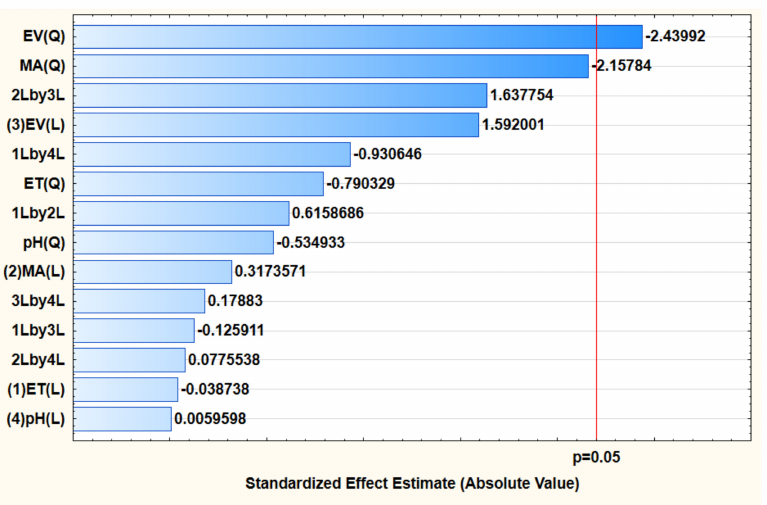
Figure 5. Pareto chart of standardized factors for the extraction of trenbolone. Factor (Q): Factor (quadratic); factor (L): Factor (linear); 2Lby3L: MA-EV (mass of adsorbent and eluent volume) interaction; 1Lby4L: ET-pH (extraction time—solution pH) interaction; 1Lby2L: ET-MA (extraction time—mass of adsorbent) interaction; 3Lby4L: EV-pH interaction; 1Lby3L: ET-EV interaction; 2Lby4L: MA-pH